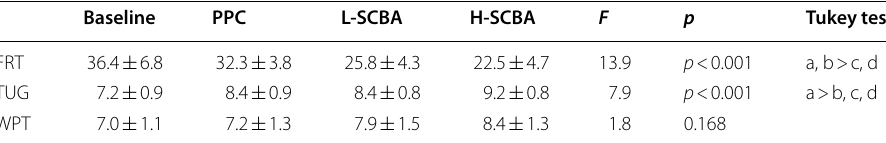
The values are presented in seconds (s) Results are presented as mean a: Baseline, b: PPC, c: L-SCBA, d: H-SCBA